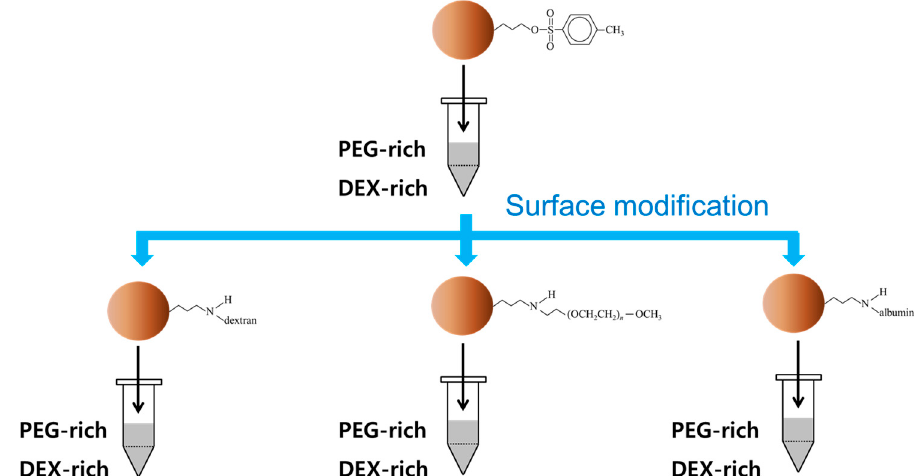
Figure 2. Partition observation in the aqueous two-phase system (ATPS) with three different surface- modified PS microparticles and one unmodified tosyl-activated Dynabead ® . Amino-dextran (aDEX), methoxy polyethylene glycol amine (mPEG), and bovine serum albumin (BSA) were used for comparison with the unmodified case.